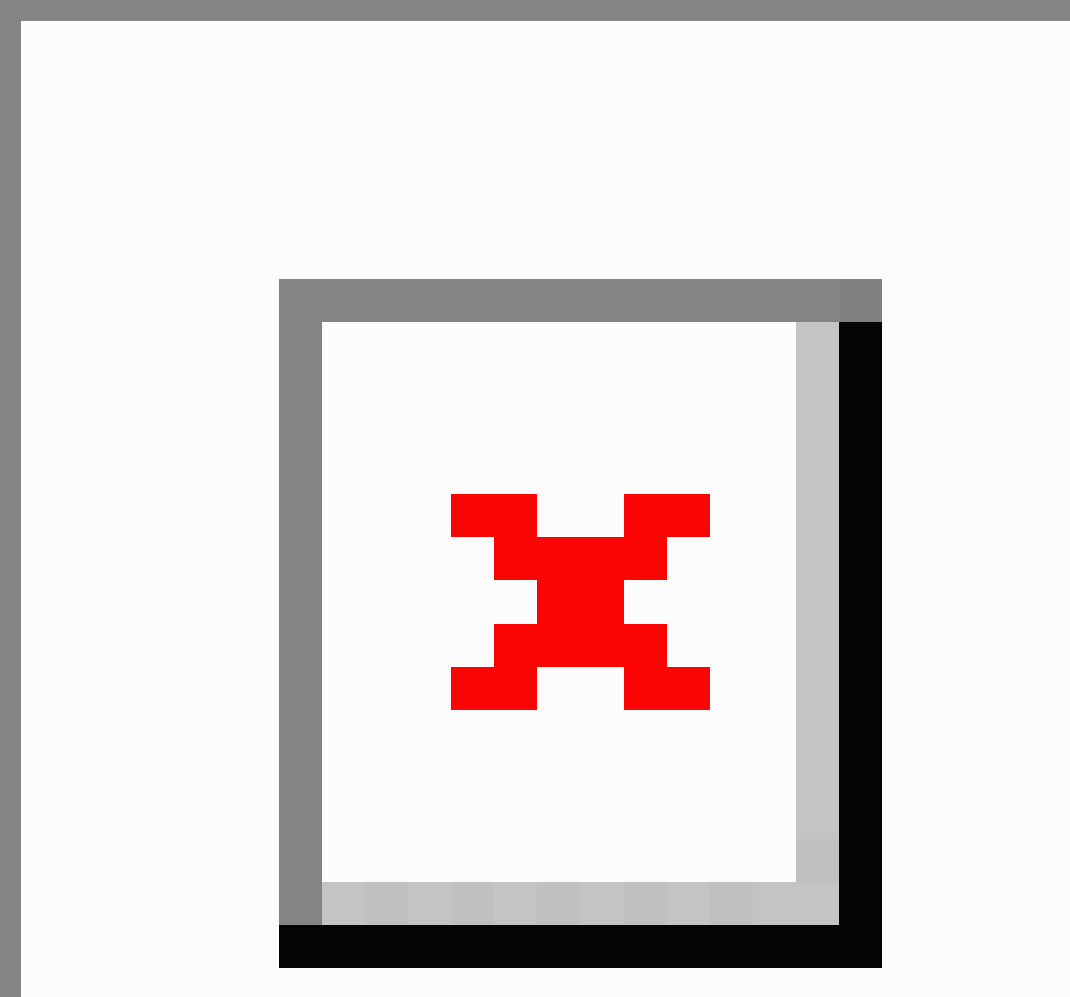
Figure 4. Result of data matching between the continuous glucose monitoring system signal and the electronic